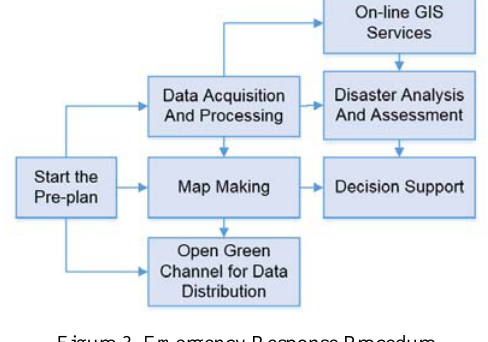
Figure 3. Emergency Response